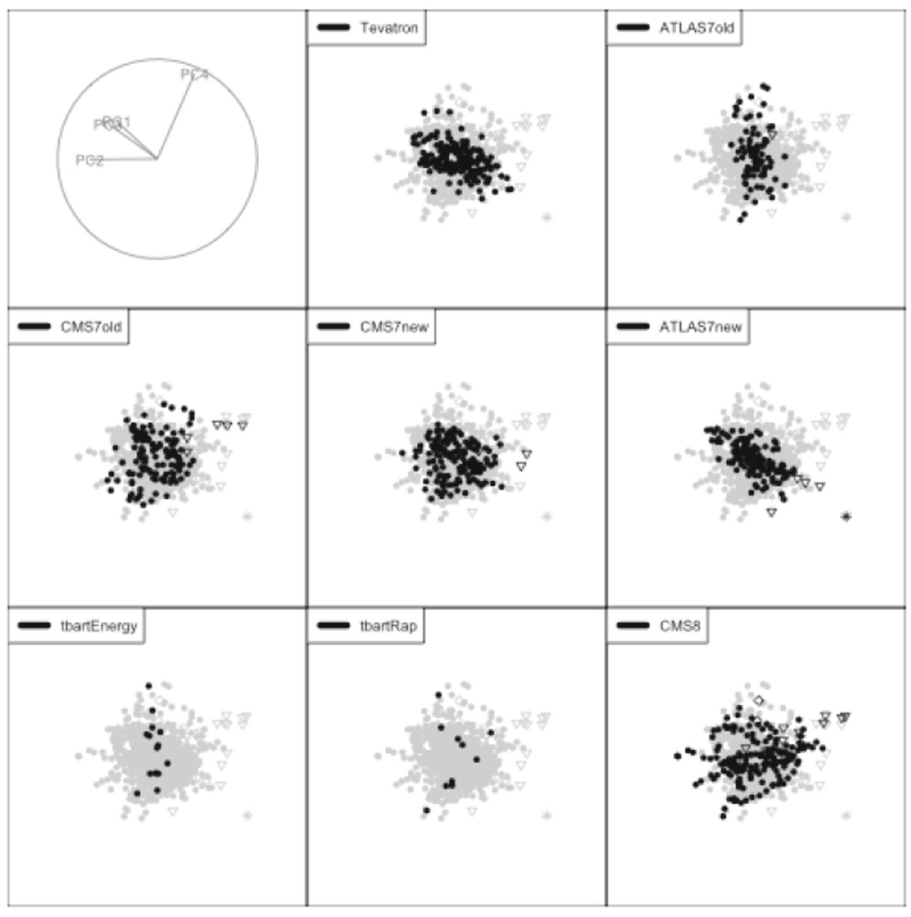
Fig. 7 Focusing on the jets cluster, showing only the first 4 PCs. Top left plot shows the projection coordinates, groups (Tevatron, ATLAS7old, ... ) are focused in black in each plot, and grey shows all the data enabling direct comparison between subgroups. This view